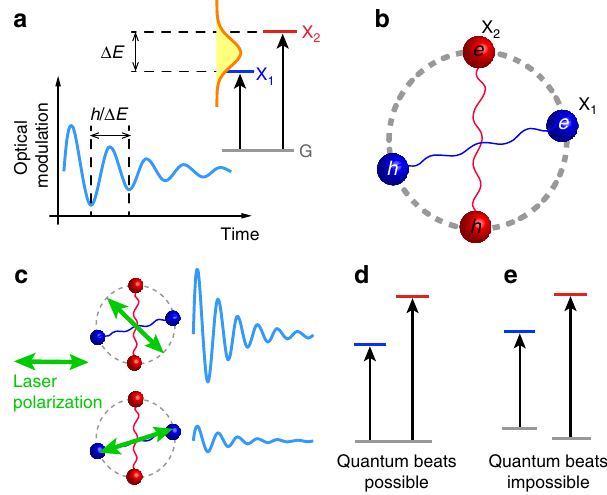
Fig. 1 Quantum beats in ReS 2 . a Coherent superposition of resonantly excited two excitons (blue (X 1 ) and red (X 2 ) states) can lead to beating optical signals in the time domain (light blue oscillation). The oscillation period corresponds exactly to the energy different ( Δ E ) of the excited states. b Illustration of anisotropic excitons (dumbbell-shaped electron – hole pairs) in ReS 2 . The two lowest excitons, X 1 and X 2 , are linearly polarized with different in-plane orientations. c Controlling quantum beats (light blue oscillations) of excitons by manipulating laser polarization (arrows). Blue (red) color represents X 1 (X 2 ). While the quantum beat